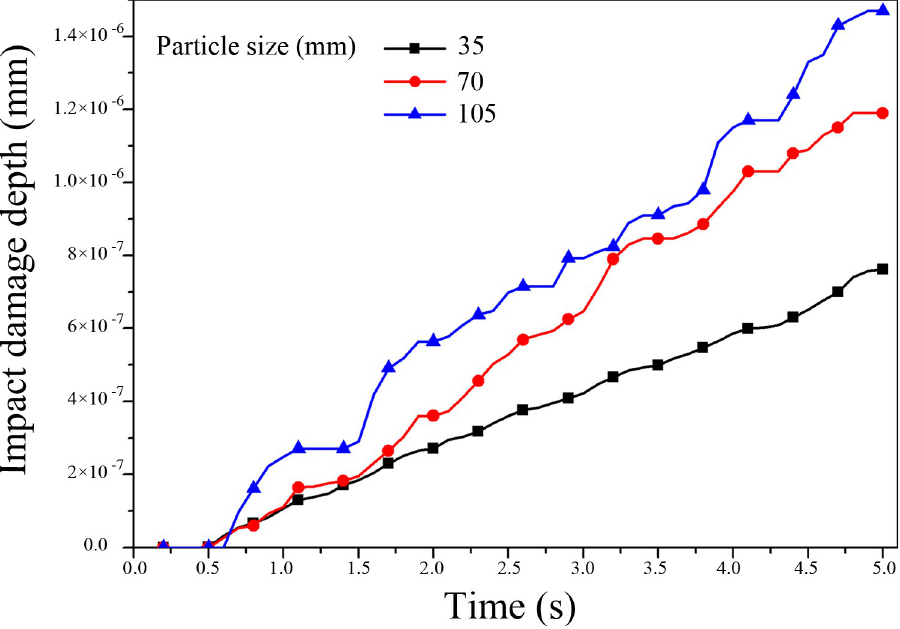
Fig 12. Curve of the impact damage depth of the middle trough caused by raw coal with different particle sizes. https://doi.org/10.1371/journal.pone.0266831.g012 the normal cumulative contact energy. Shi and Zhu [3] and Glushkova [4] investigated the influence of the particle size and moisture content of raw coal on the damage to the middle trough, and they found that a larger particle size leads to more prominent damage to the mid- dle trough.